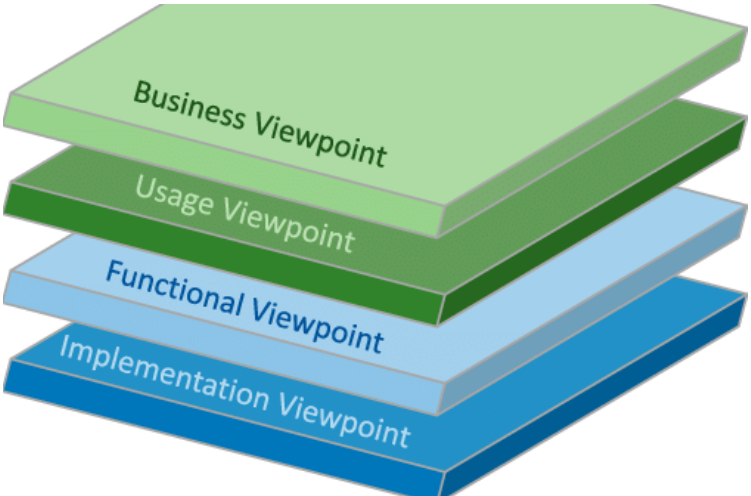
Figure 4. Industrial Internet Reference Architecture (IIRA) viewpoints for smart manufacturing